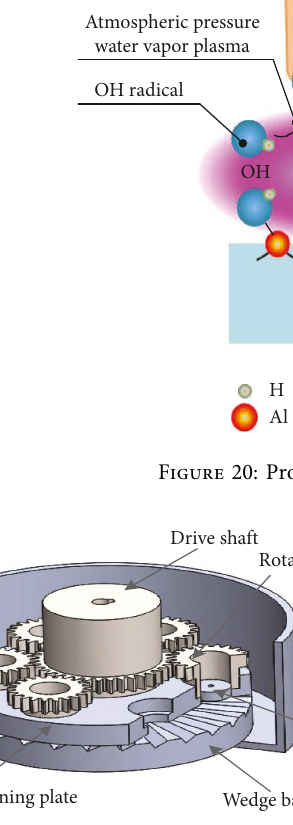
Figure 21: Hydrodynamic floating polishing principle.